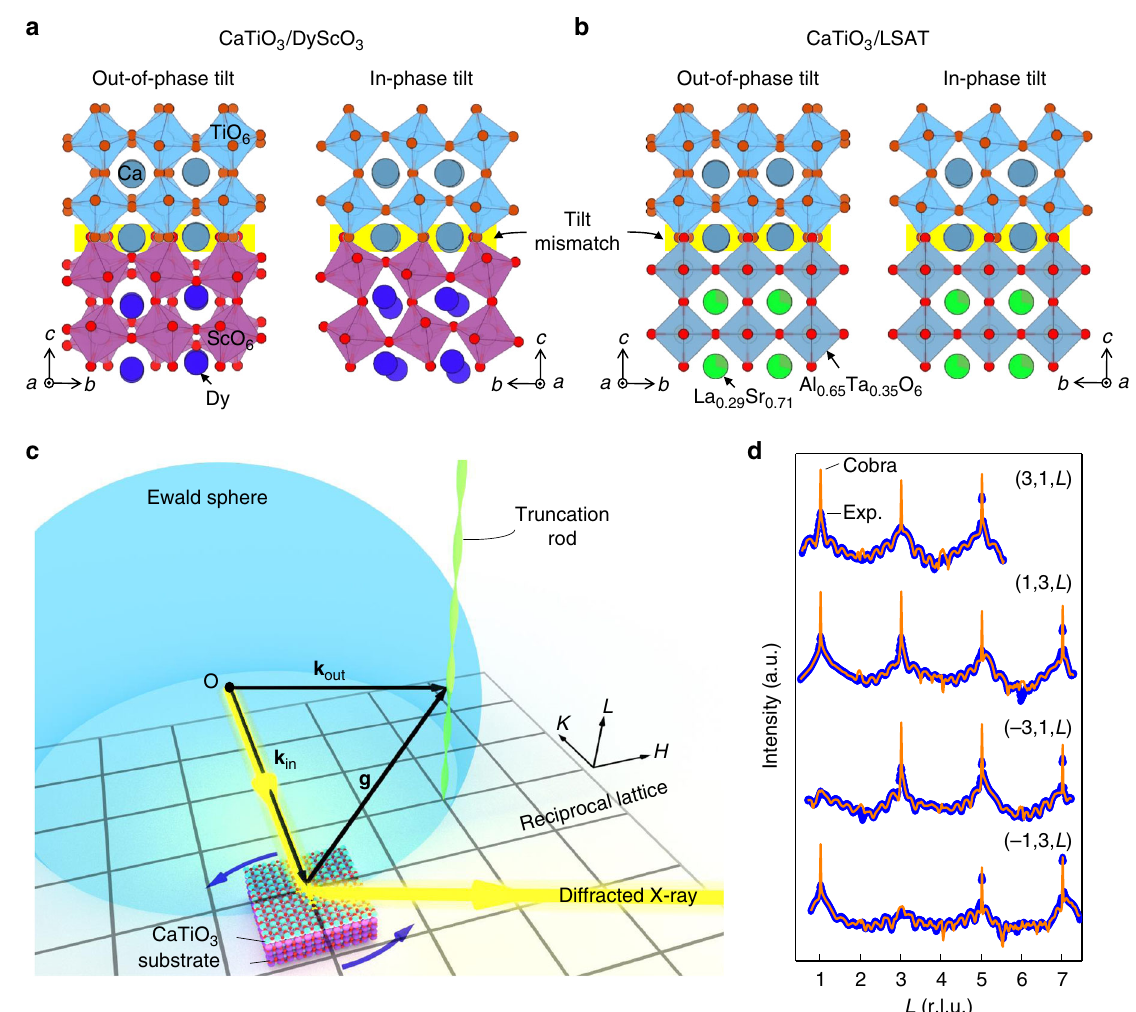
Fig. 1 The schematics of fi lm systems and CTRs measurement. Schematic of tilt mismatch across CaTiO 3 and substrate interfaces for a CaTiO 3 /DyScO 3 b CaTiO 3 /LSAT. The yellow highlighted area represents the abrupt mismatch in in-plane oxygen octahedra tilt angles. c Experimental geometry of synchrotron X-ray diffraction used in the coherent Bragg rods analysis (COBRA) is schematically shown. The diffraction intensities along crystal truncation rods (CTRs) are mapped out by varying their intersect positions with Ewald sphere through rotating the sample about its surface normal. ( H , K , L ) is the coordinates in reciprocal lattice. d Several examples of measured crystal truncation rods, labeled as ( H , K , L ), where the intensity versus the reciprocal vector L is shown (blue dots) for CaTiO 3 /NdGaO 3 at room temperature, as well as the corresponding COBRA fi ts (orange solid lines). The reciprocal units are under 2 × 2 × 2 pseudocubic notation. Note that for COBRA, the substrate Bragg peaks intensities (the trees) are not as important as the diffraction structure between the peaks (the forest fl Figure 1d displays typical COBRA fi ts (orange solid lines) to experimental CTRs (blue dots) measured on CaTiO 3 /NdGaO 3 at room temperature.